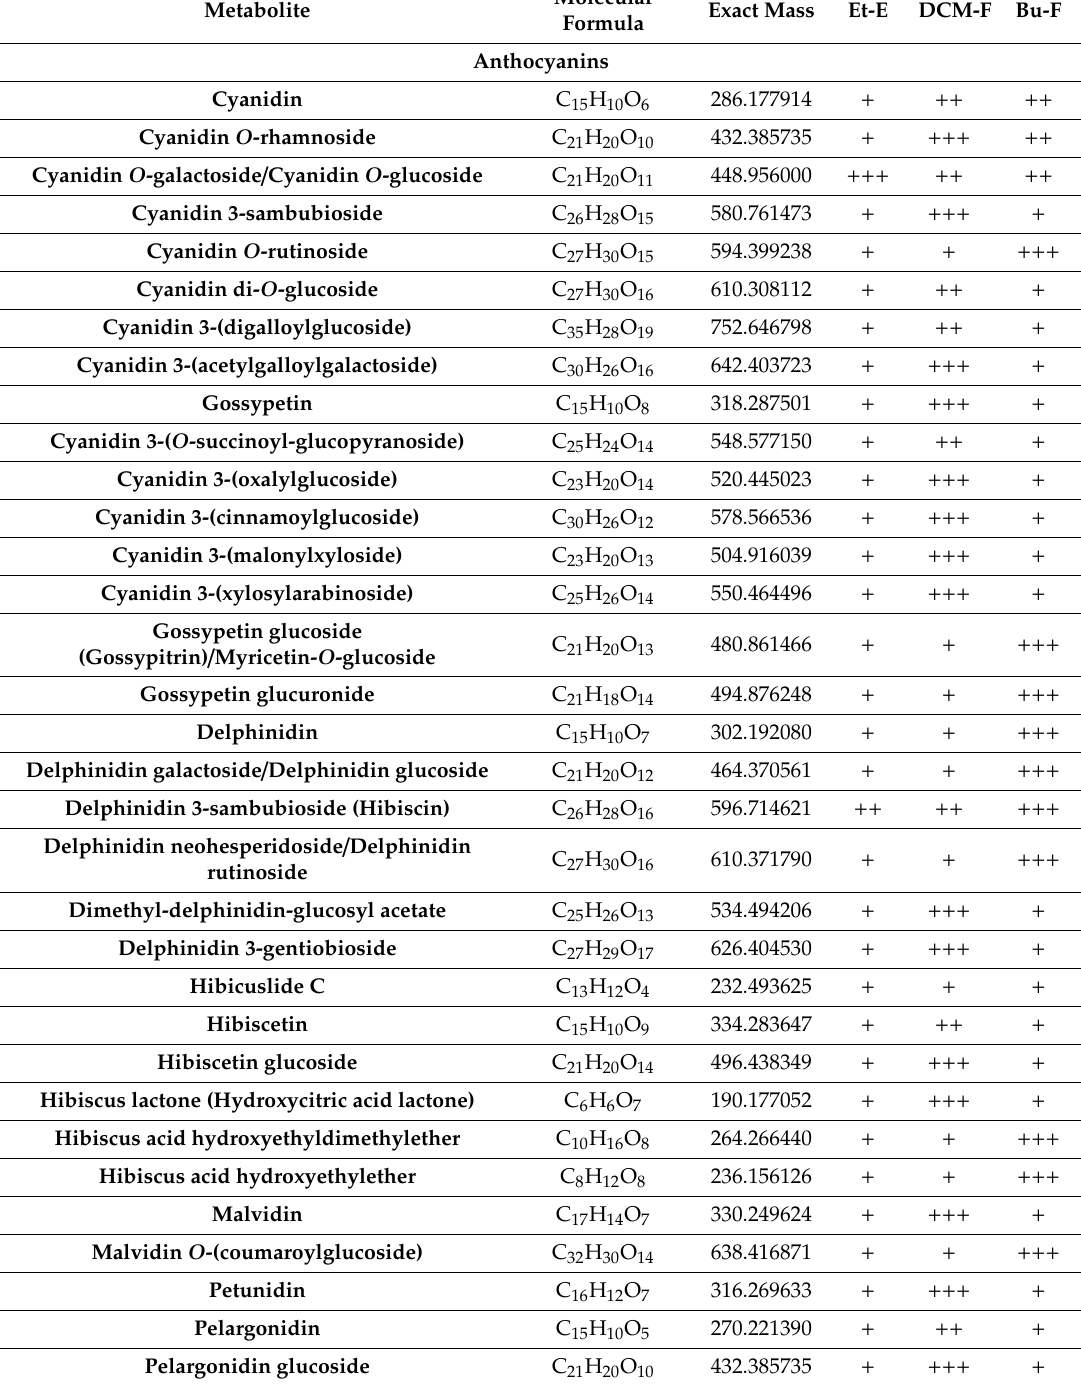
Table 5. Metabolites of Hibiscus schizopetalus (identified by